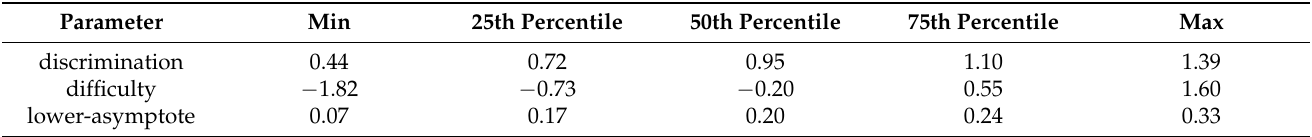
Table 2. Operational item parameter and five-point summary and